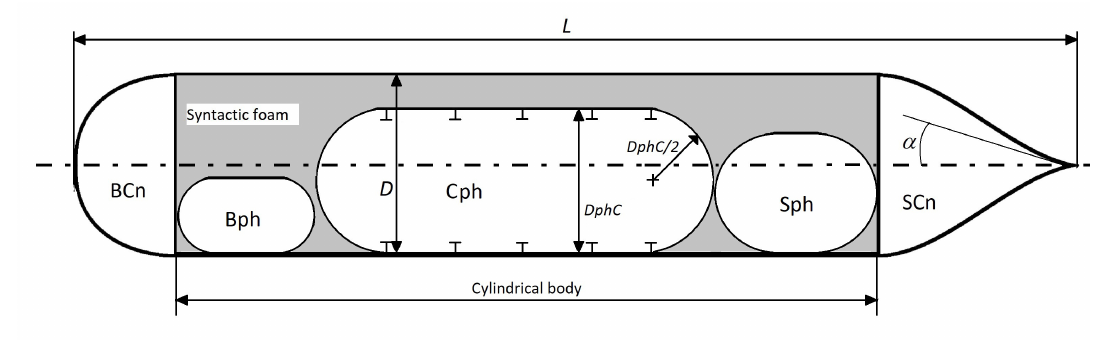
Figure 2. AUV profile. L , total length. L bow , bow cone length. D , outer diameter. DphC , central pressure hull diameter. α , exit angle. BCn, bow cone. Bph, bow pressure hull. Cph, central pressure hull. Sph, stern pressure hull. SCn, stern cone.